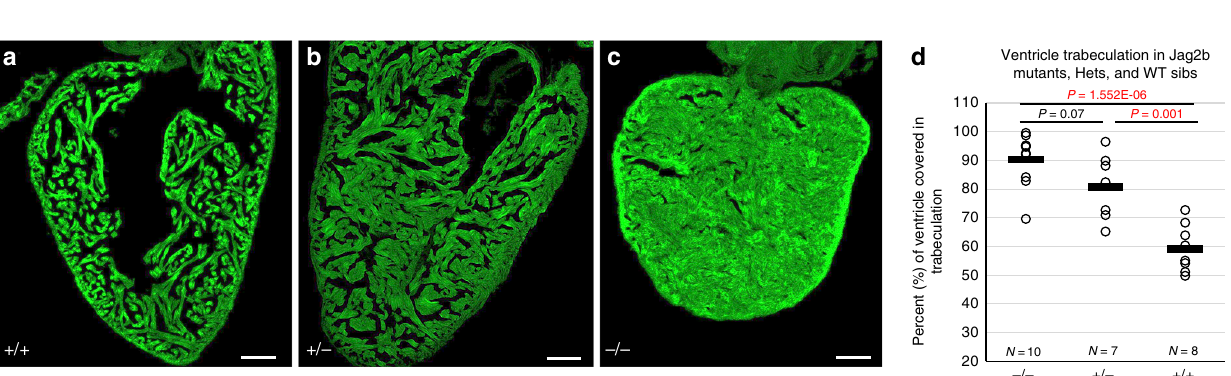
protocol 37 . Brie fl y Rabbit-anti-active-Caspase3 antibody was used (1:200, BD Pharmingen 559565) with Chicken anti-GFP (1:1000, Aves labs) in 4% PFA- fi xed